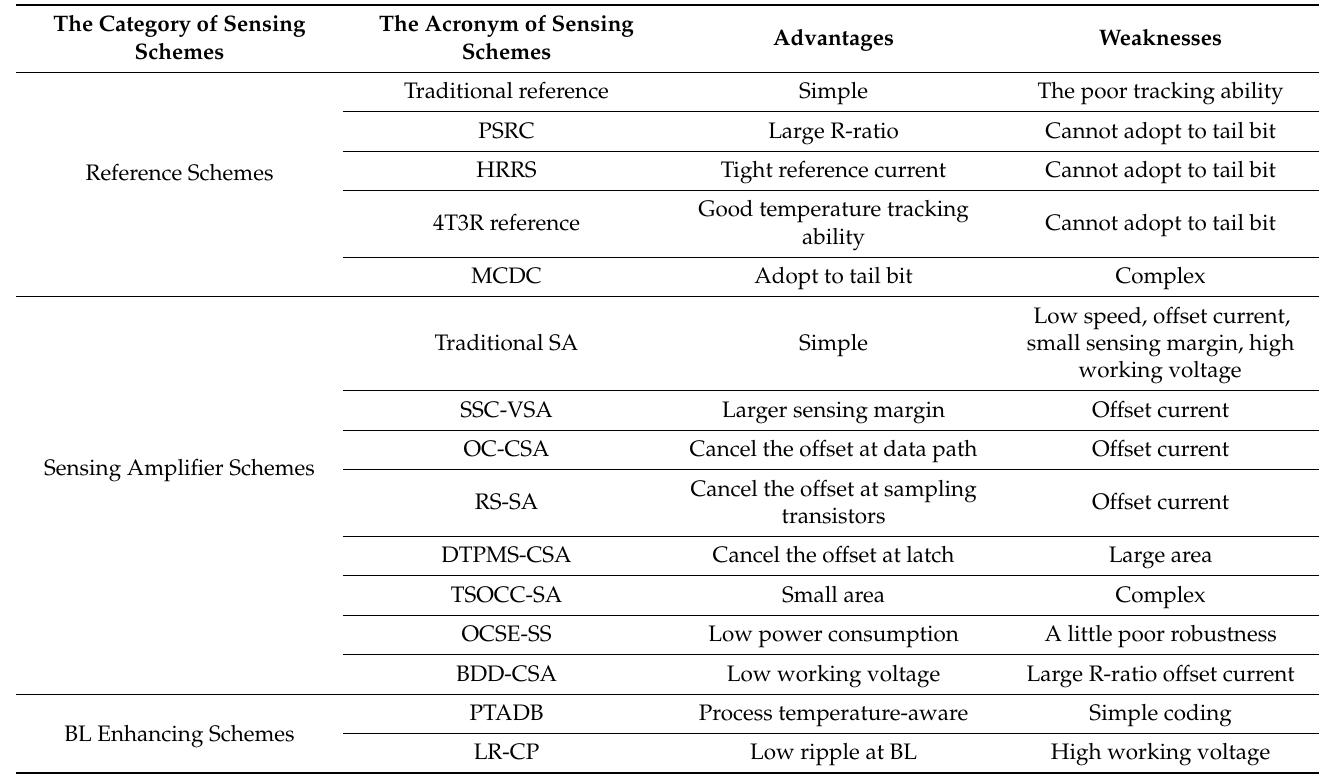
Table 2. The summary of sensing schemes and the advantages and weaknesses of each